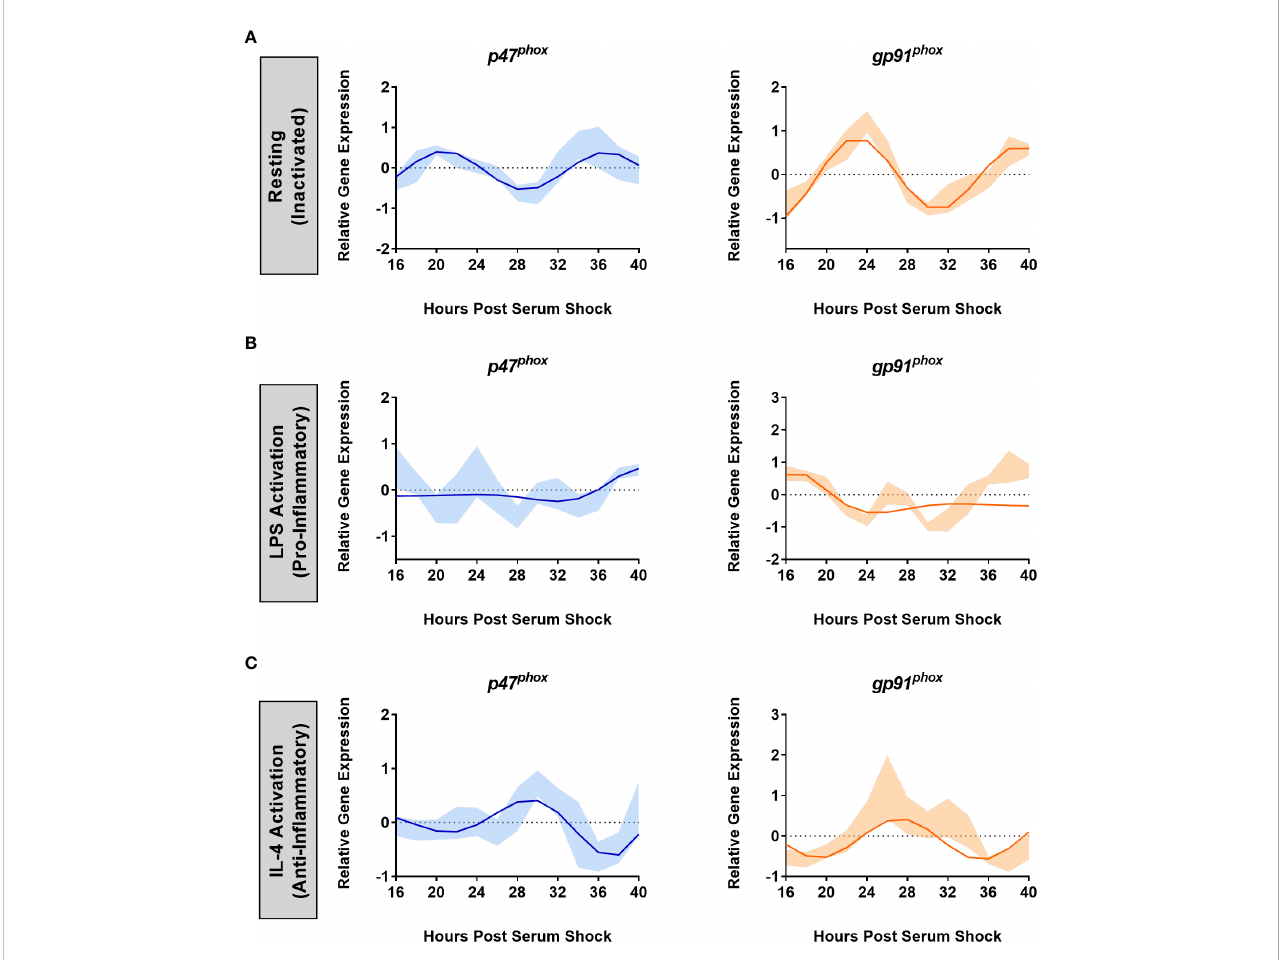
FIGURE 3 NOX2 sub-units p47 phox and gp91 phox are under the control of the BV2 microglial circadian clock. ECHO fi tted plots for mRNA expression of NOX2 components gp91 phox and p47 phox in BV2 microglia (n = 3) under (A) resting, (B) LPS (1 µg/mL) (pro-in fl ammatory) and (C) IL-4 (20 ng/mL) (anti- in fl ammatory) activation. Data represented as fold change in expression using Hprt1 as a reference gene and HSP0 as a reference sample for the DD Ct method of data analysis. Bold line represent model fi t with shaded region representing the standard deviation of model at each time point. All plots had p < 0.05 for ECHO signi fi cance fi